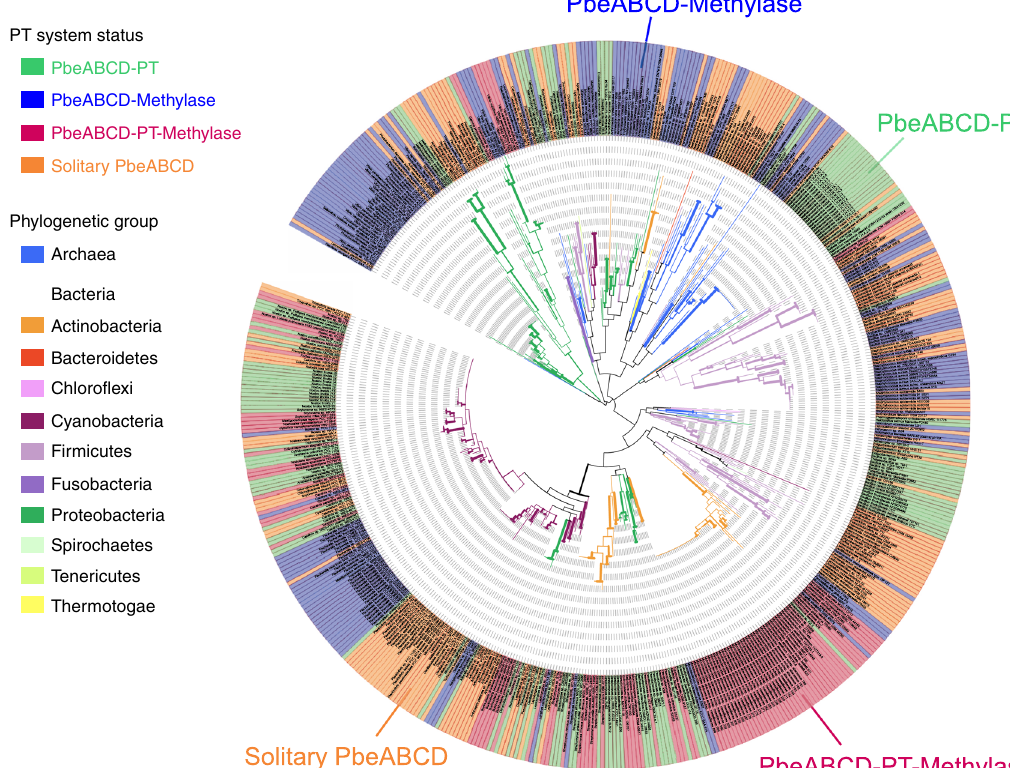
Fig. 6 Phylogenetic analysis of 553 PbeAC proteins. Each archaeal and bacterial group is represented in a distinct colour. Green (128) and blue (155) shading indicate the presence of DndCD for phosphorothioate (PT) modi fi cation or MTase for methylation within the vicinity of PbeAC. One-hundred and fi ve PbeAC homologues have DndCD and MTase simultaneously present within the de fi ned neighbourhood (1 bp – 10 kb), while 165 PbeAC homologues are solitary, lacking the modi fi cation component within the neighbourhood. Source data are provided as a Source Data fi